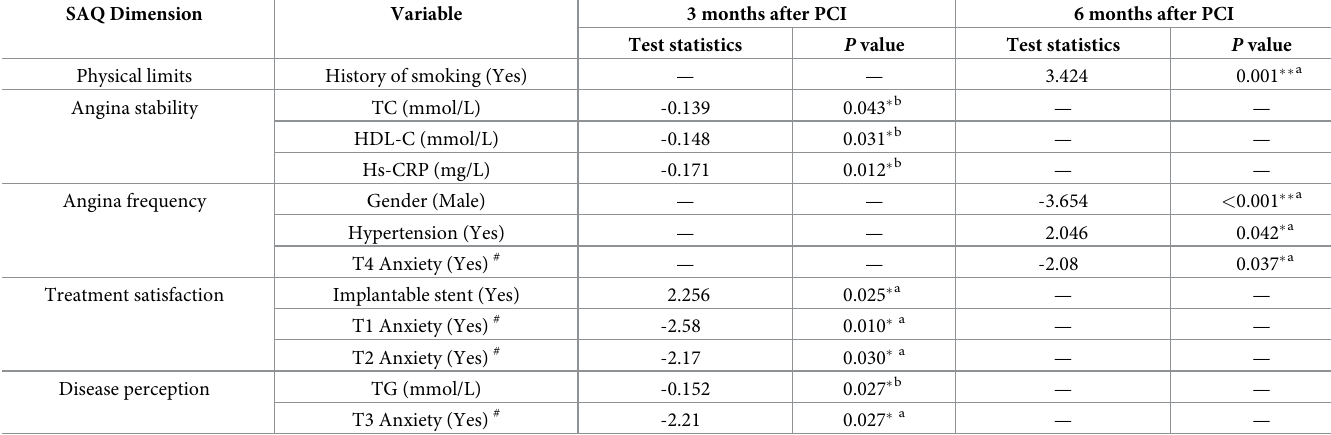
a Mann-whitney U test was used to analyze the relationship between SAQ dimensions and independent variables at 3 and 6 months after PCI. b Pearson correlation was used to analyze the relationship between SAQ dimensions and independent variables at 3 and 6 months after PCI. # Less than 50 means no anxiety, and greater than or equal to 50 means anxiety [21, 22].